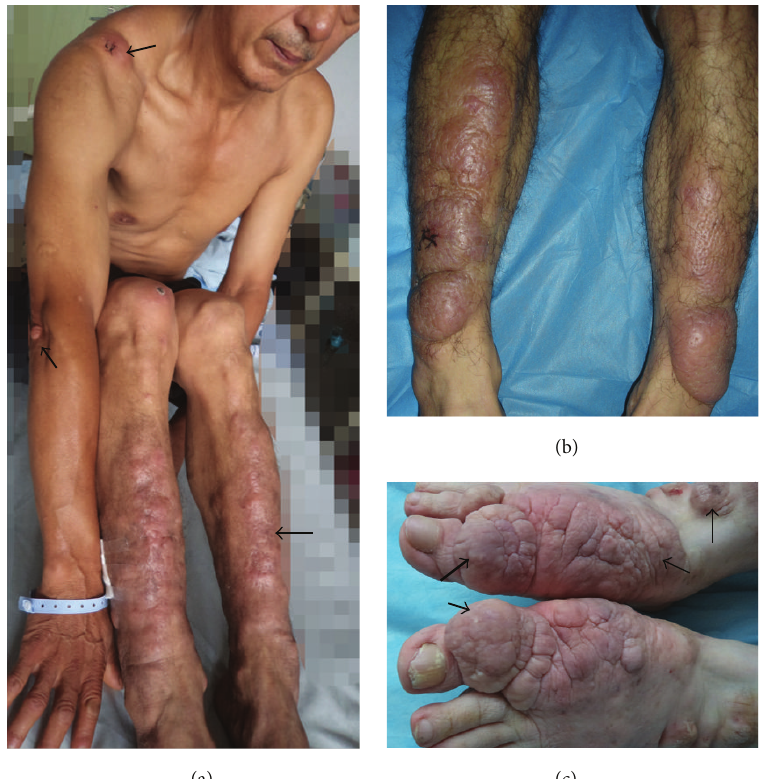
Figure 5: Mixture variant. (a) 4 × 4 cm hemisphere tumor with orange peel-like appearance on the right shoulder, a keloid-like nodule at the extensor of right elbow, and nodules and plaques on the lower two-thirds extensors of lower legs. (b) Red tumors and plaques on the extensors of lower legs. (c) Wide arrows indicated tumors on the first toes; a fine arrow showed red plaques with polypoid appearance on the back of feet and a red nodule at the flexor aspect of right